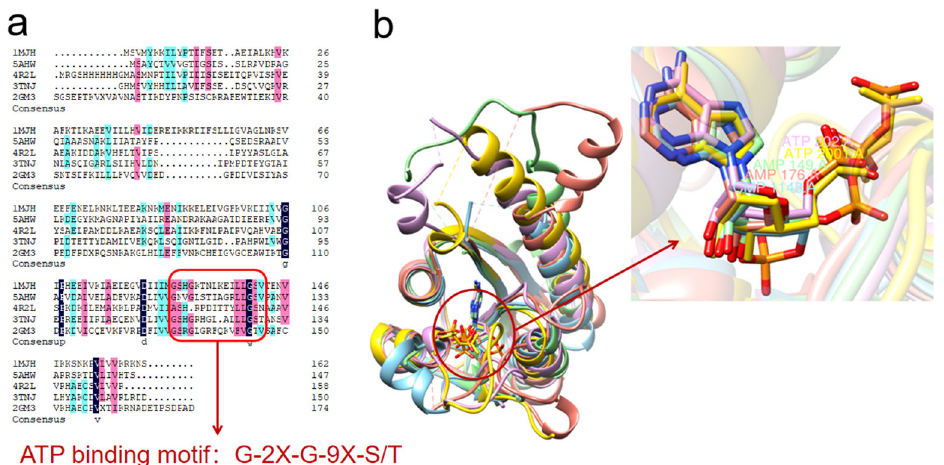
Figure 2. USPs binding analysis. Crystalline small molecules containing ATP or ATP analogs (AMP, ANP, etc.) were selected for sequence comparison and structure superimposition. ( a ) Sequence comparison. All except 4R2L contain ATP-binding motifs: G-2X-G-9X-S/T. ( b ) Superposition. 1MJH, 5AHW, 4R2L, 3TNJ and 2GM3 are gold, blue, purple, green and red, respectively. Superposition of